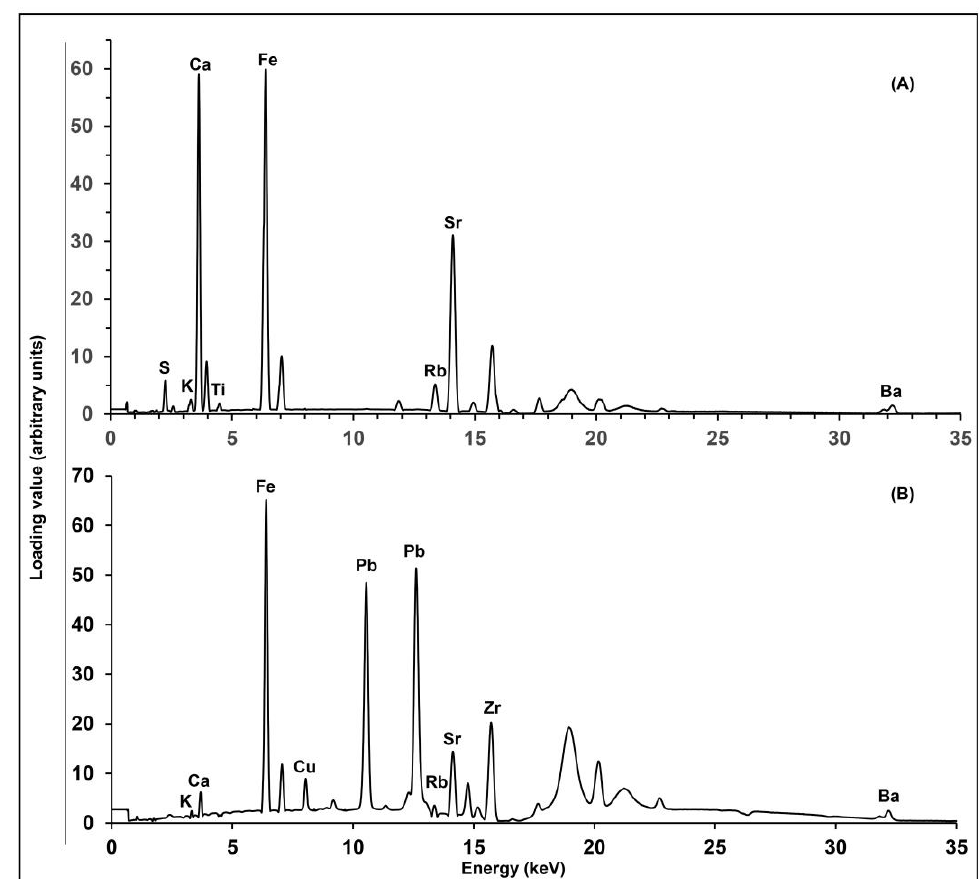
Figure 5. Plot of loading vectors versus energy (keV) for the XRFS analysis of the New Mexico ( A ) and military installation ( B ) soil samples. Only the K α lines are identified for the most significant loading values, except in the case of the Pb L α and L β lines. Peaks associated with the Rh X-ray source and the broad Compton scattering peaks are also not